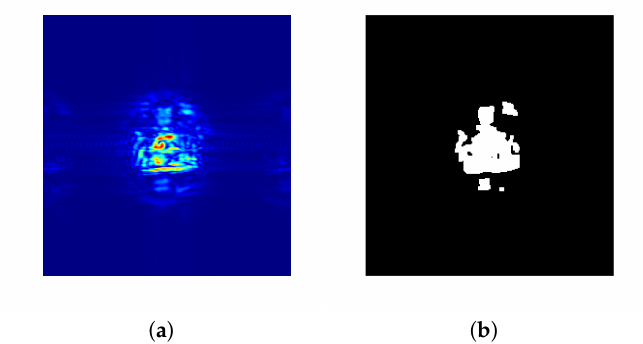
Figure 29. Billfold: ( a ) Scan; ( b ) Segmented image.